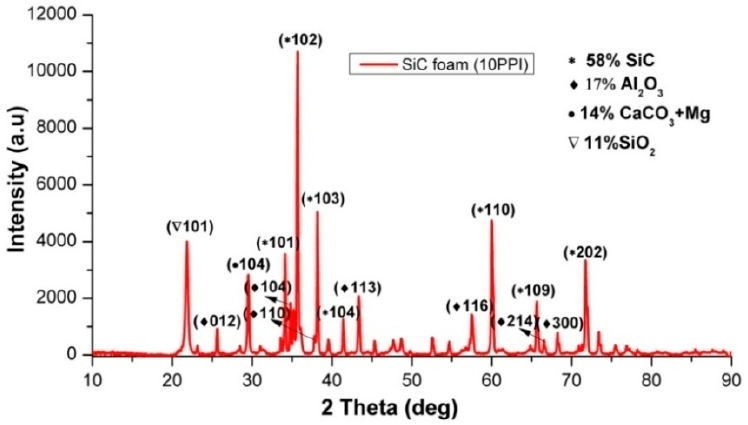
Figure 2. XRD pattern of F10.